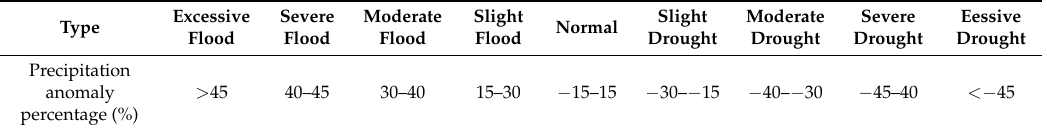
Table 2. Classification of droughts and floods according to the precipitation anomaly percentage index.